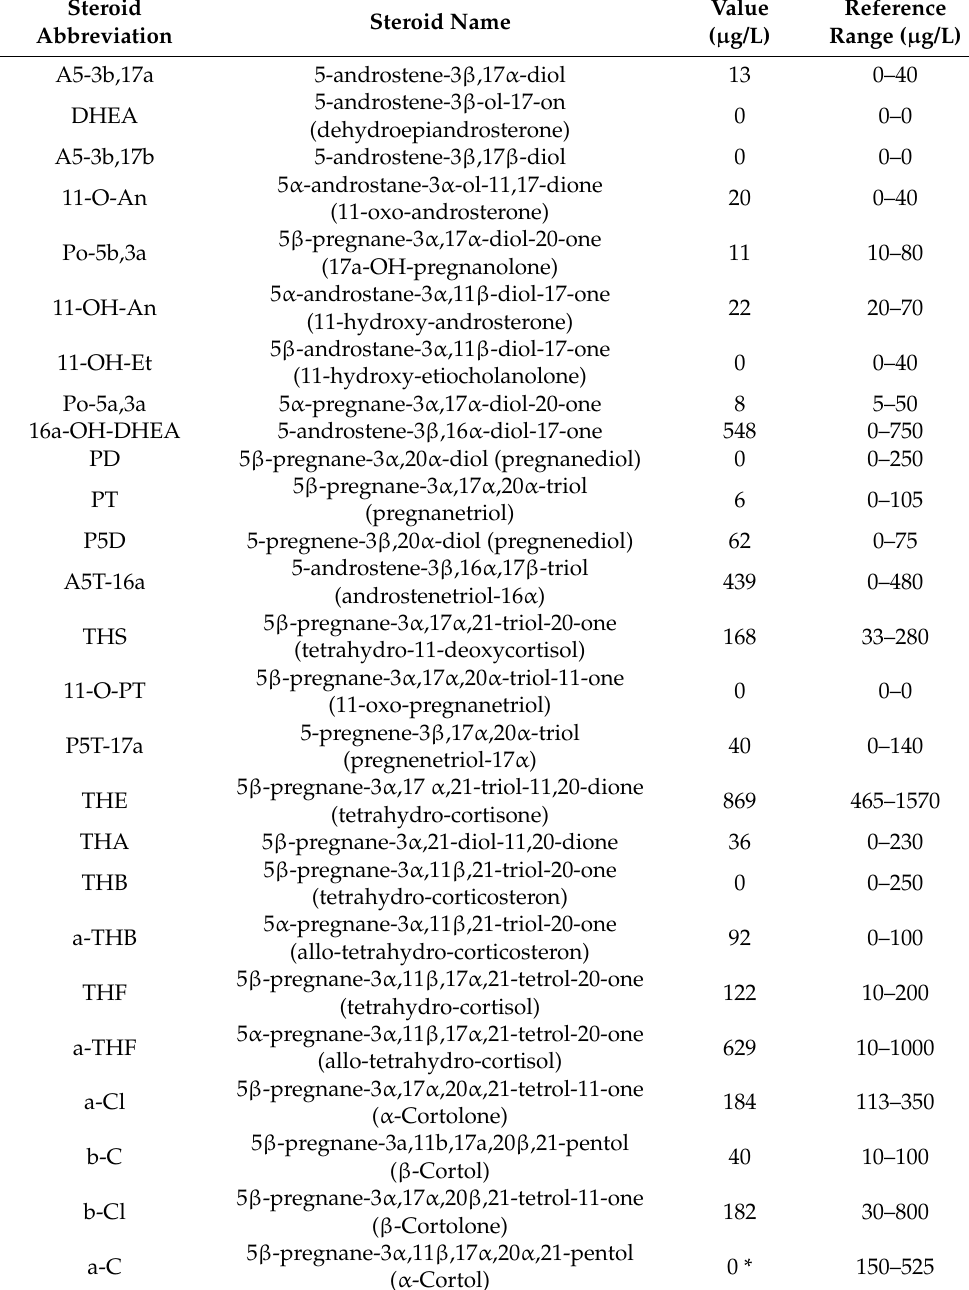
Table 1. GC-MS urinary steroid metabolome analysis in patient 3. Spot urine was collected at the age of 6 months prior to hydrocortisone treatment initiation. Abnormal results are indicated by